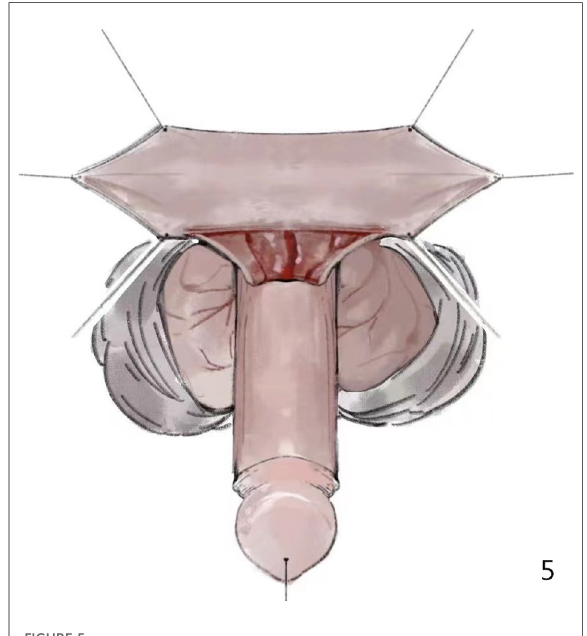
FIGURE 6 The resulting free graft was anastomosed to the separated urethra plate with interrupted